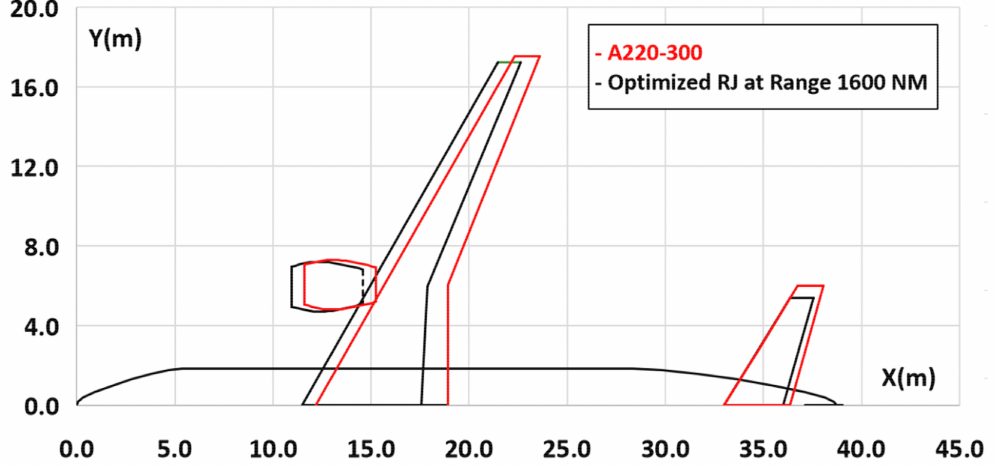
Figure 15. Comparison between top views of the baseline regional jet model (red) and the selected optimum regional jet aircraft